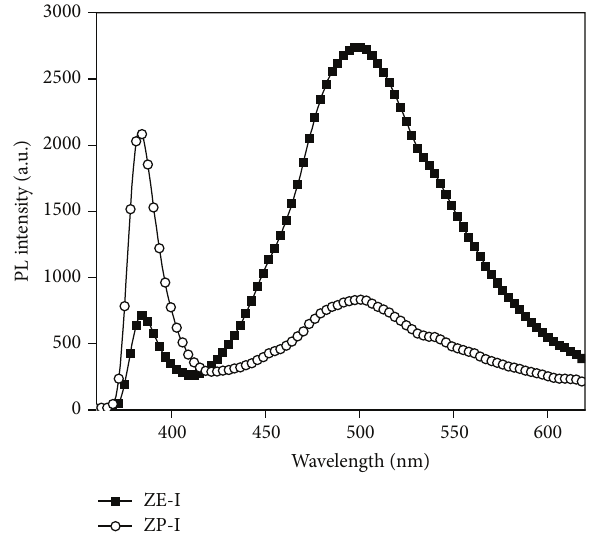
Figure 2: PL spectrum of ZP-I (propanol-based films) and ZE-I (ethanol-based